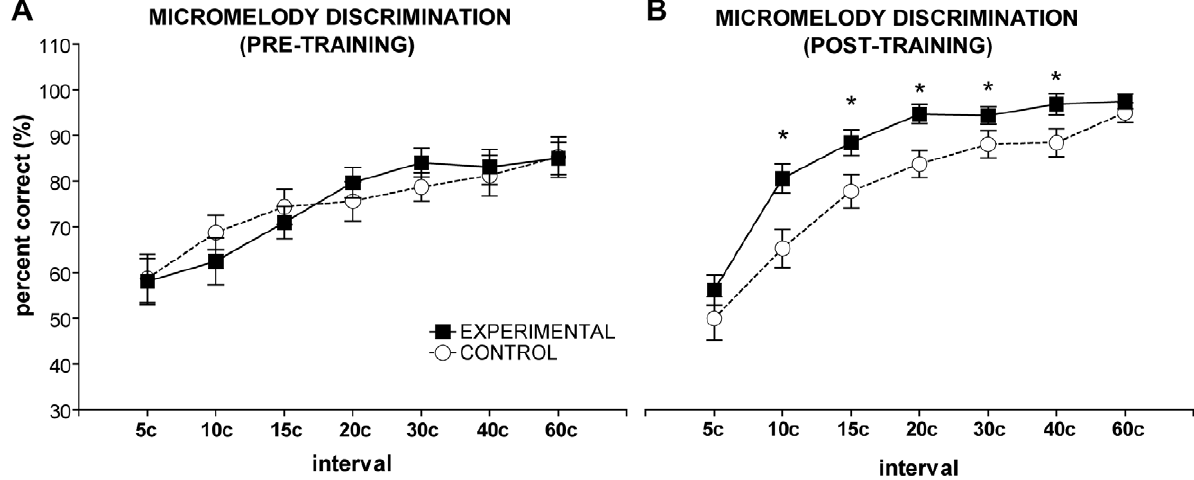
Figure 1. Performance on micromelody discrimination task before and after training. A: Prior to training, both groups of non-musicians performed similarly across all micromelody interval scales. B: After training, the experimental group exhibited better micromelody discrimination with intervals of 10–40 c, compared to controls (denoted by *, all p s # 0.05).